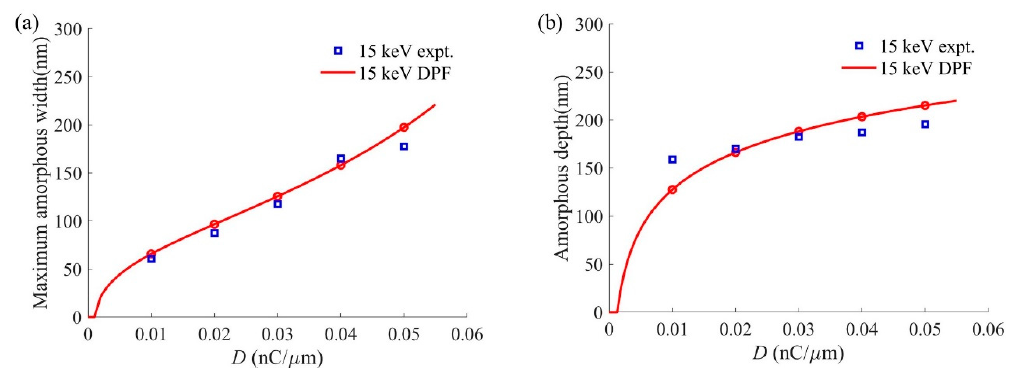
Figure 12. Comparison of experiments and DPF calculations of the amorphous damage profile characteristic dimensions of silicon substrate treated with He-FIB at a beam energy of 15 keV: ( a ) Maximum amorphous width; ( b ) Amorphous depth.